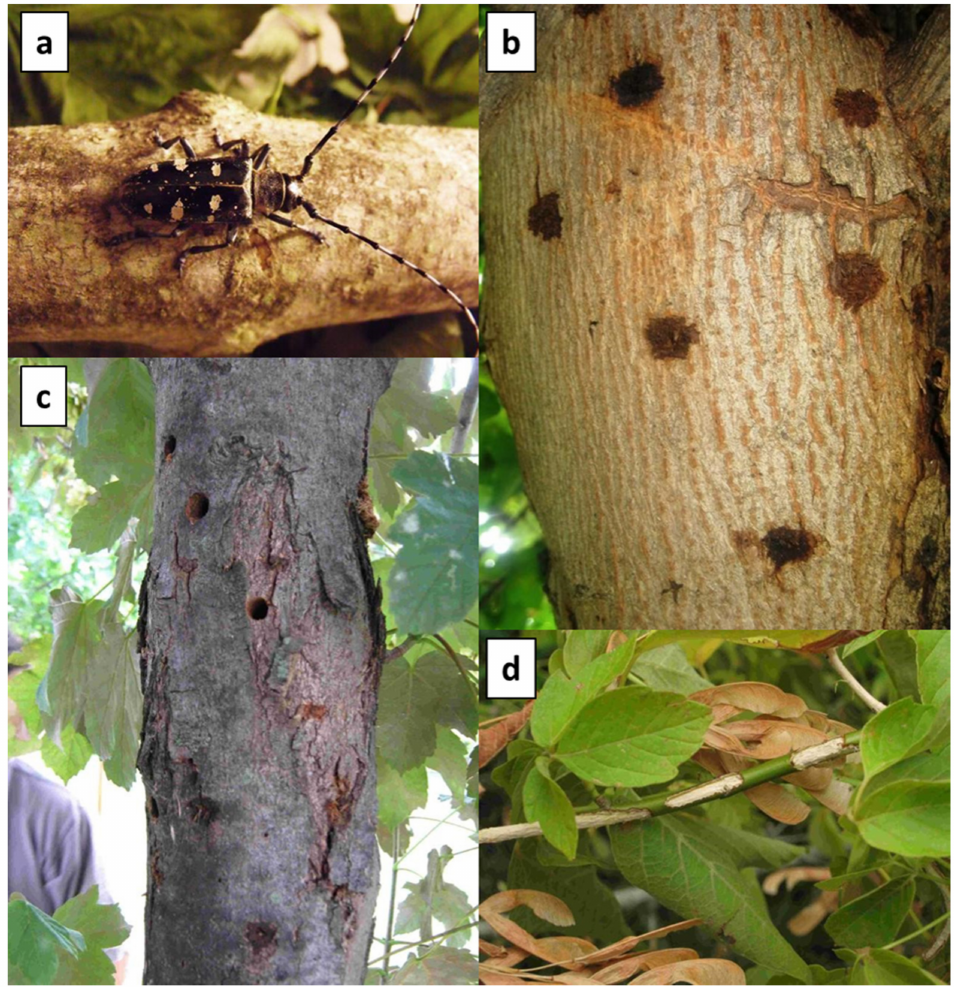
Figure 1. Main symptoms of A. glabripennis infestation: presence of adults ( a ), adult exit holes ( b ), oviposition scars ( c ), maturation feedings on twigs ( d